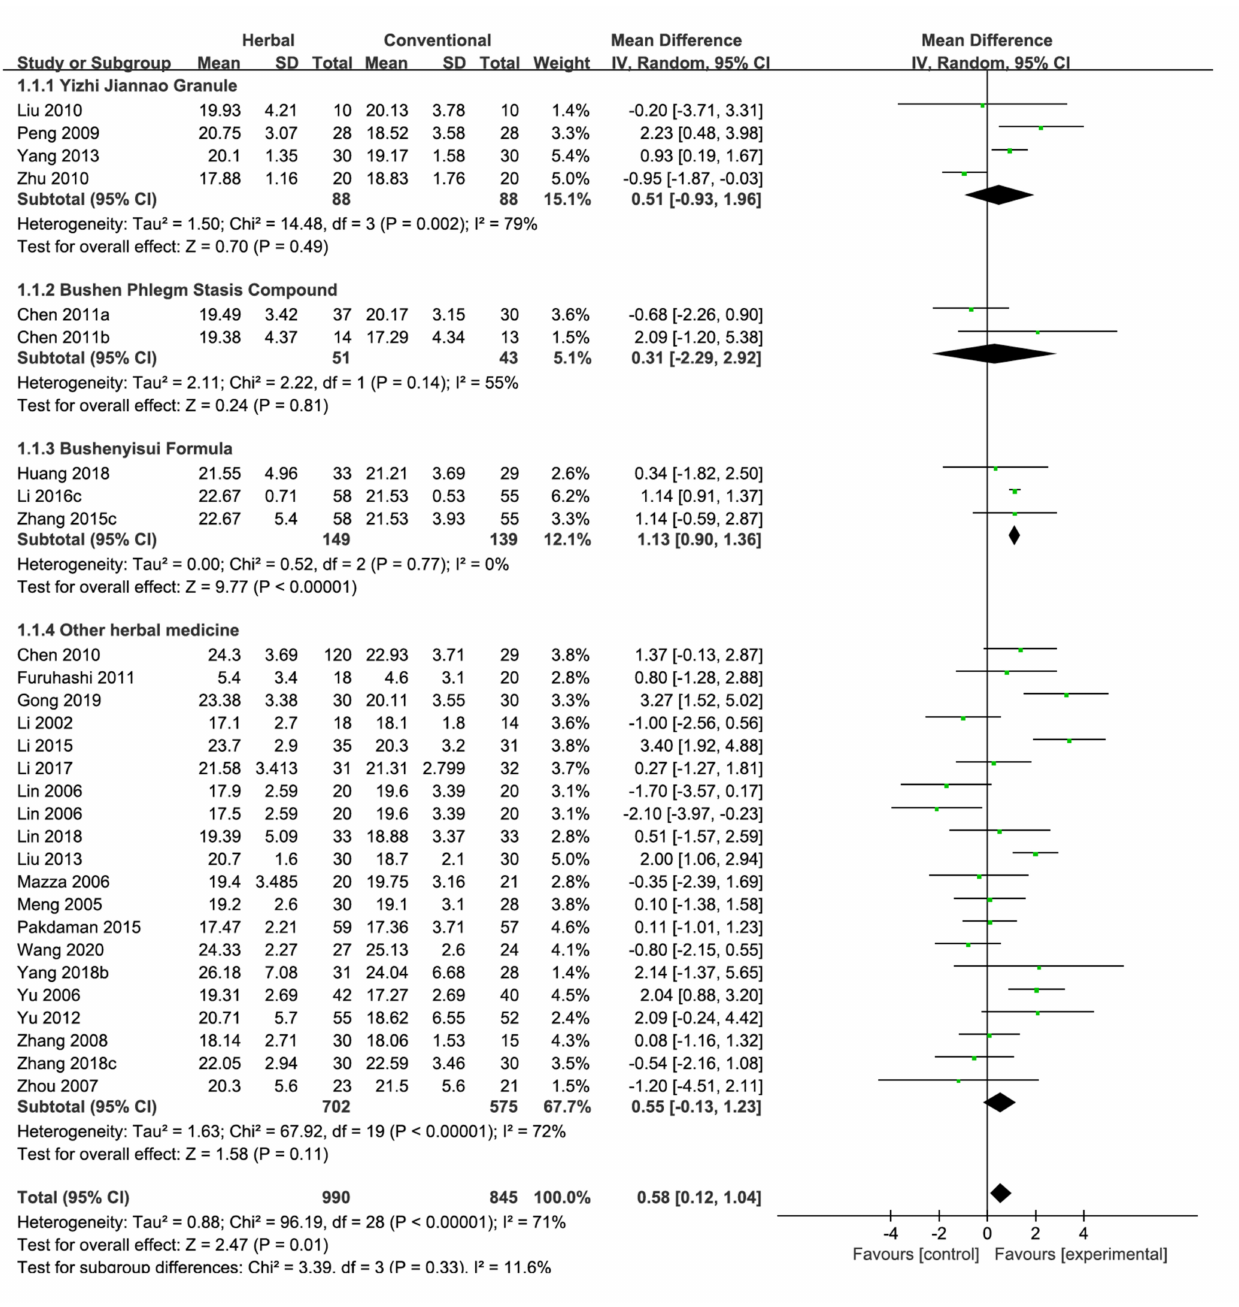
Figure 3. Forest plot for MMSE: Herbal medicine vs. Conventional